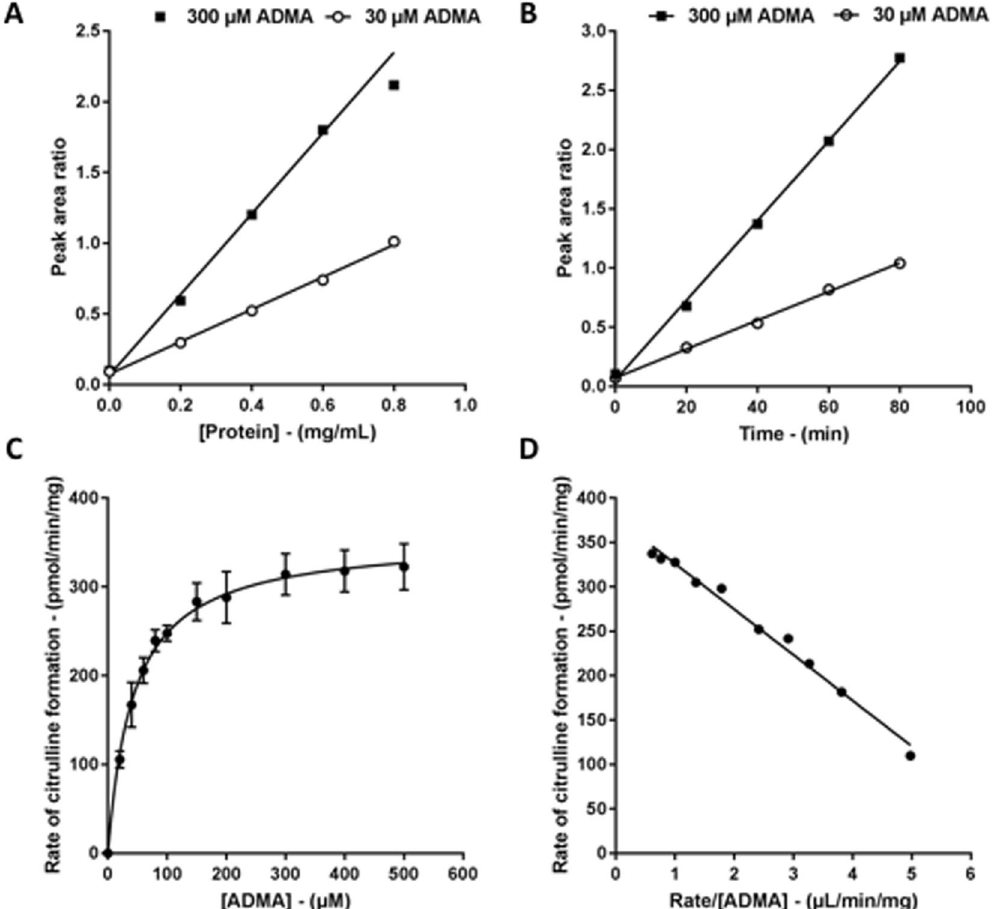
Figure 1. Kinetic plots representing the conversion of ADMA to L-citrulline by DDAH11. Protein linearity ( A ) and time linearity ( B ) data were collected in singlicate. For ADMA concentration versus rate ( C ) each data point is the mean of three singlicate experiments and error bars represent the standard error. The data is represented as an Eadie-Hoffstee transform in ( D ). The Michaelis-Menten fit is shown as a solid line in panel C and D .